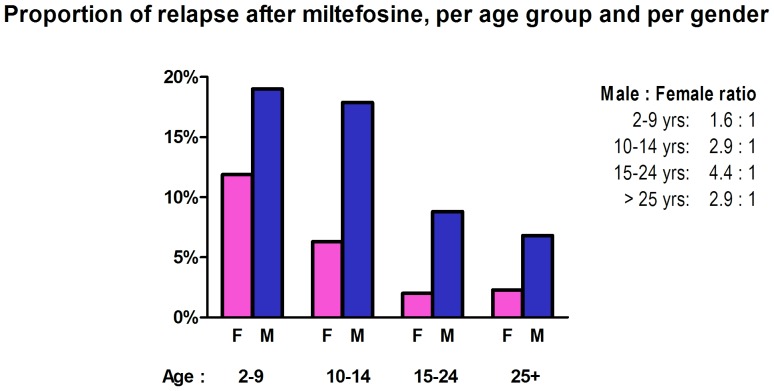
Percentage of Relapse per age and gender.